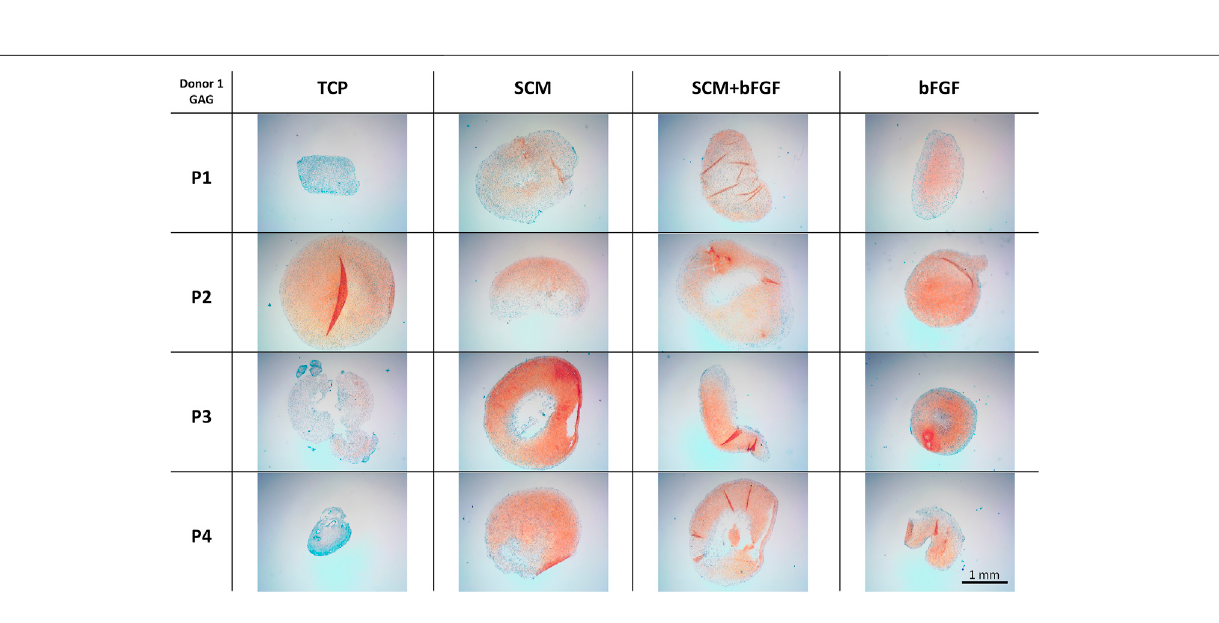
Frontiers in Bioengineering and Biotechnology |